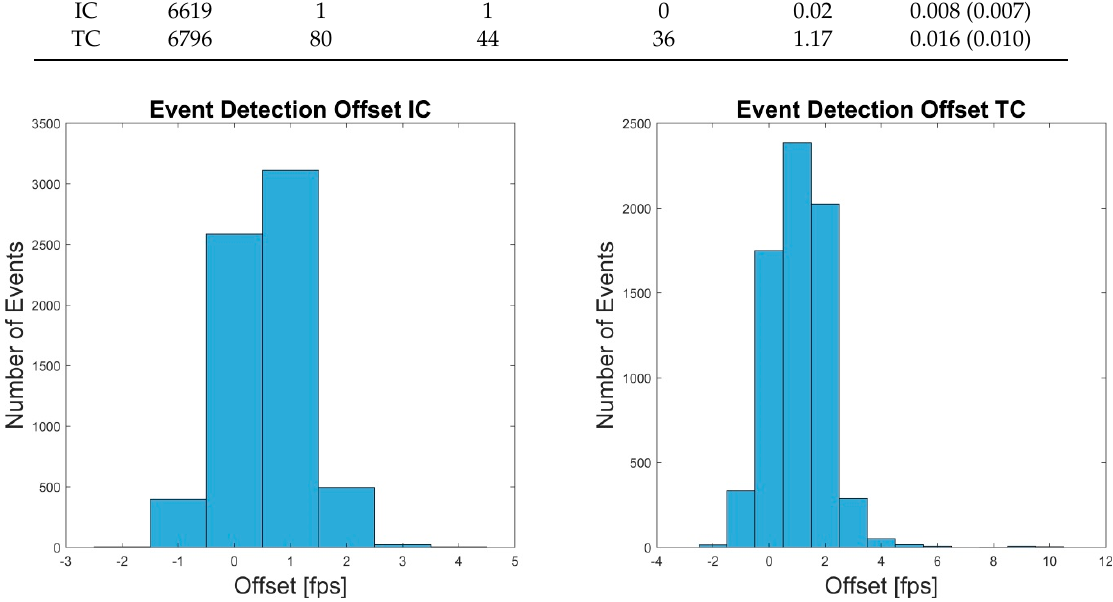
Figure 5. The Offset in frames per second (fps) between OMC and IMU system for the IC and TC events of test 1 are